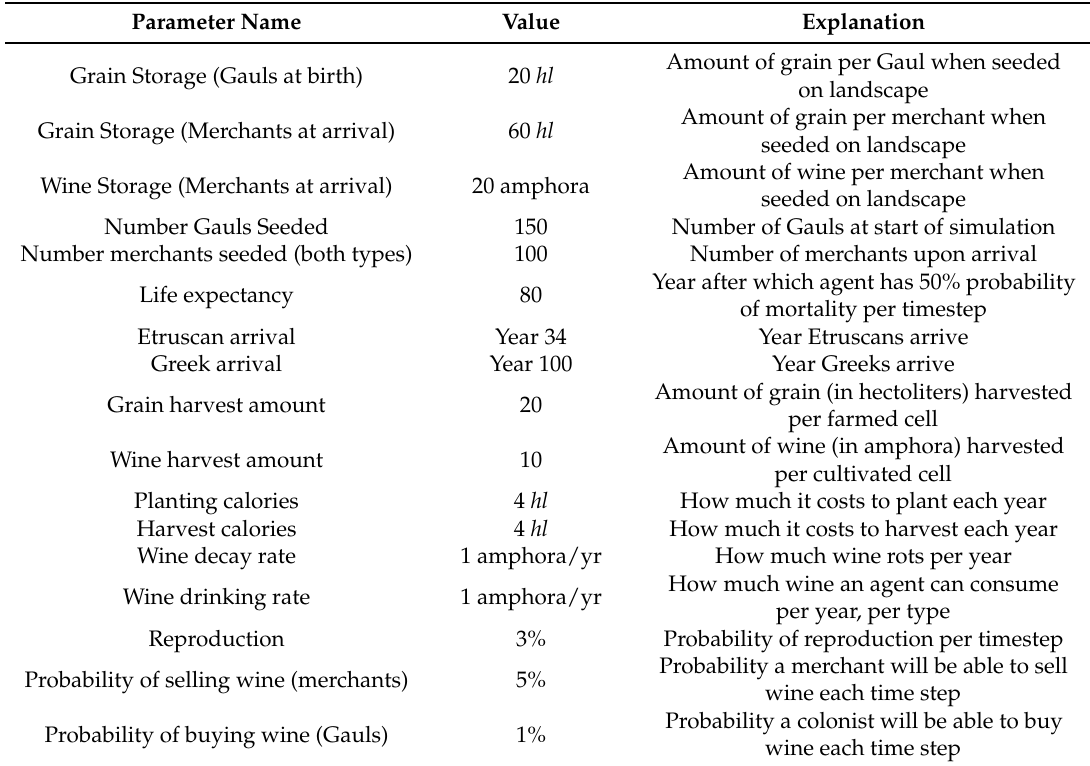
Table 2. Fixed parameters used in this simulation. Many of these were tested in earlier sweeps, which are not reported here.